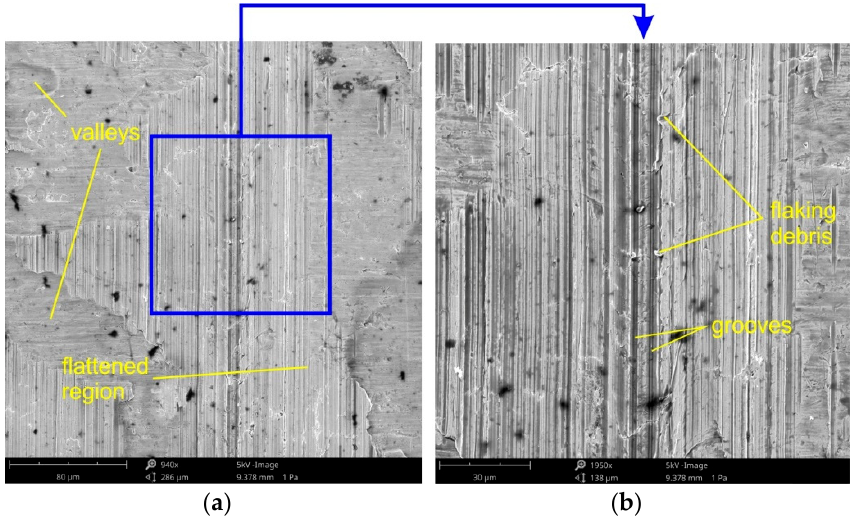
Figure 21. The specimen surfaces tested in dry friction (Ra = 0.63 μ m, h = 12 mm, w = 14 mm, ori- entation 90°) at different magnifications: ( a ) ×940 and ( b ) ×1950.